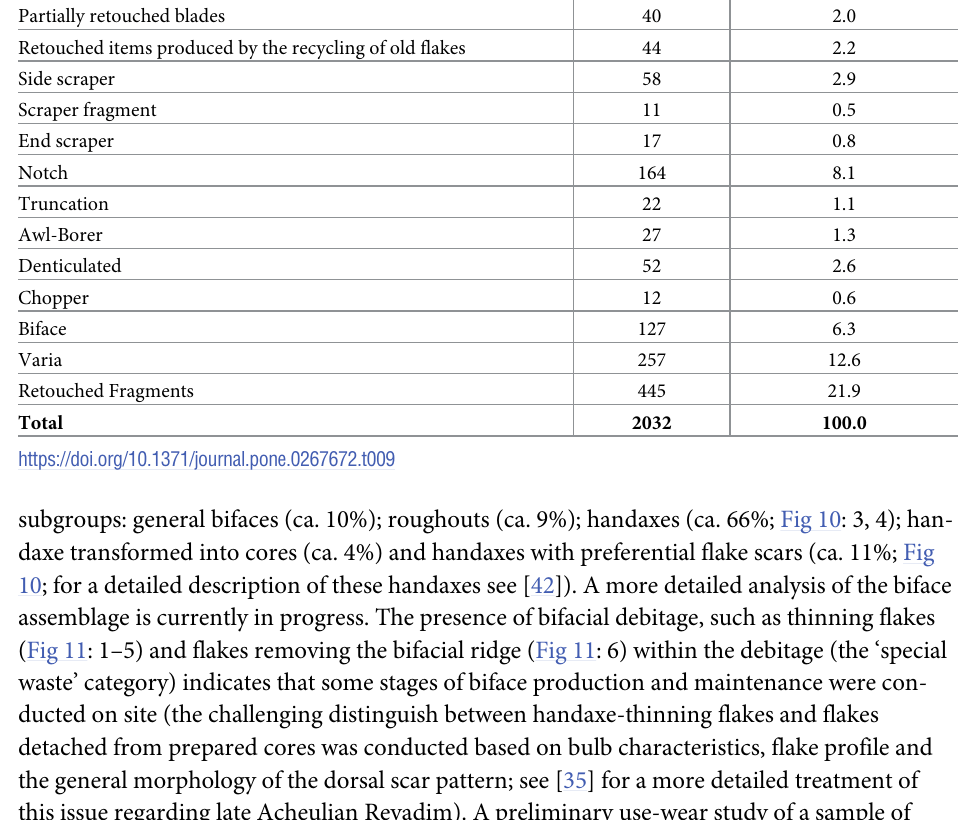
Retouched items produced by the recycling of old